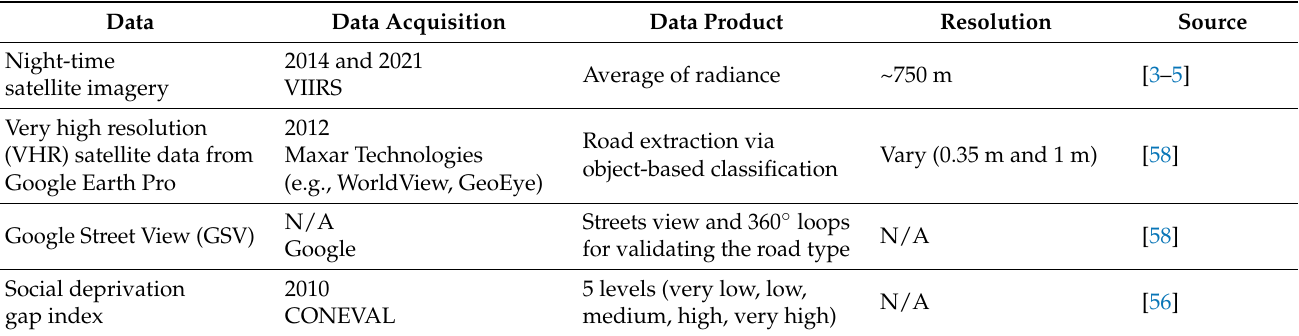
Table 2. Data sources and